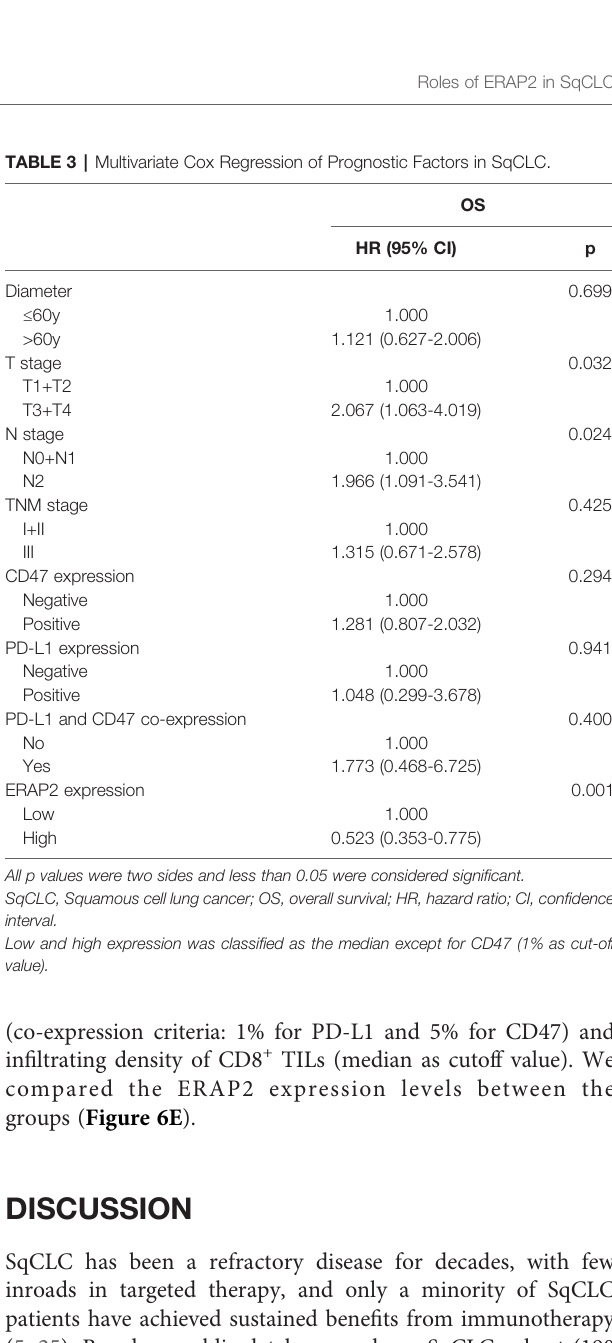
TABLE 2 | Univariate Cox Regression of Prognostic Factors in SqCLC.